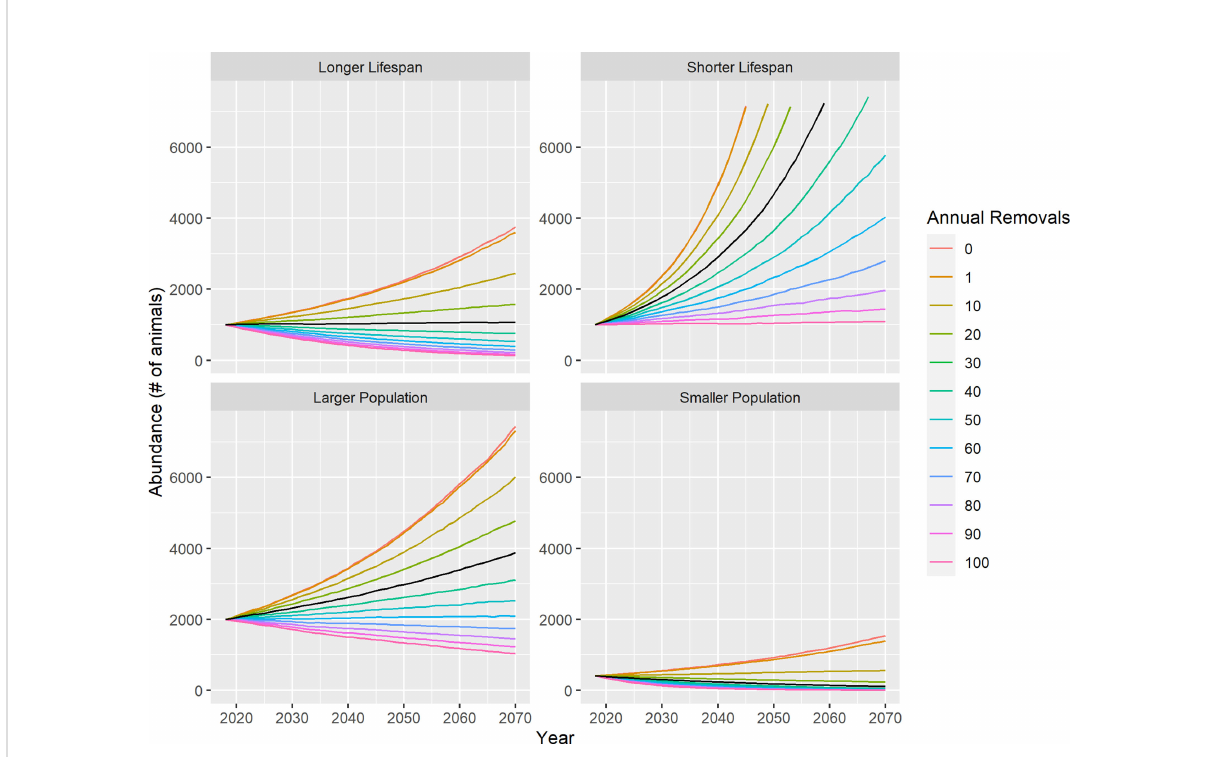
FIGURE 3 Predicted median abundance for the four life history scenarios at each level of removals, when abundance was projected one generation (53 years) into the future for white shark in southern Africa (2018-2070). The black line identi fi es removals of 30 animals per year, which is approximately the long-term average for mortalities from the KZNSB bather protection